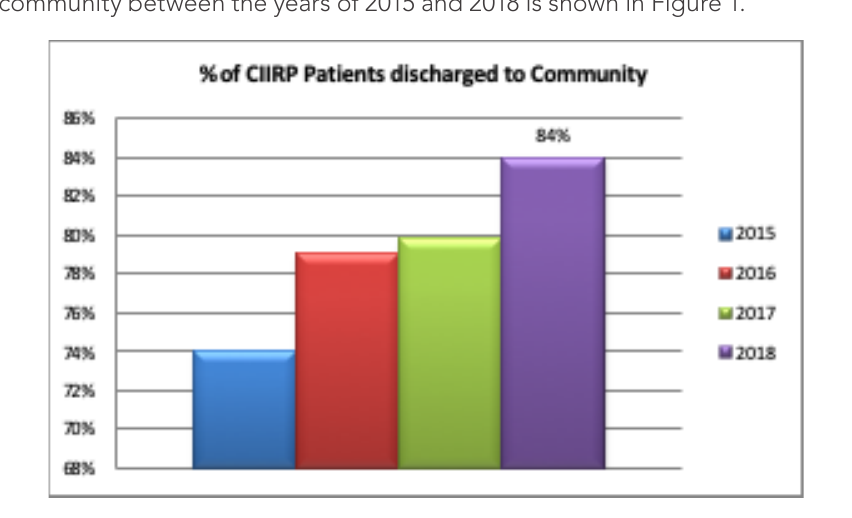
Figure 1. The percentage of patients discharged to the community in 2015- 2018.